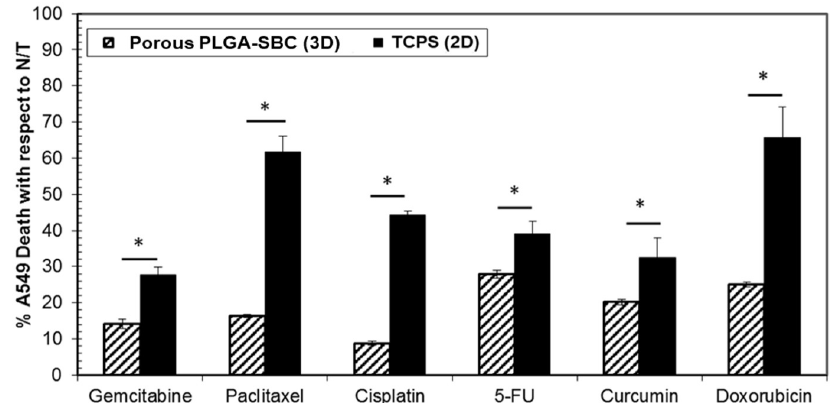
Fig 6. In vitro cancer drug screening. Effectiveness of chemotherapeutic drug treatment on A549 2D monolayer grown on TCPS and porous PLGA particles was quantified using LDH assays. It was observed that cancer drugs reduced only ~20–30% of A549 growth on the particles compared to its 2D counterparts when treated with the same concentrations of drugs. The percentage of A549 cell death was calculated with respect to untreated cells (N/T) lysed with triton. Data was statistically significant (n = 3, � p < 0.05) when compared between two models (2D vs. particles) for each treatment groups.